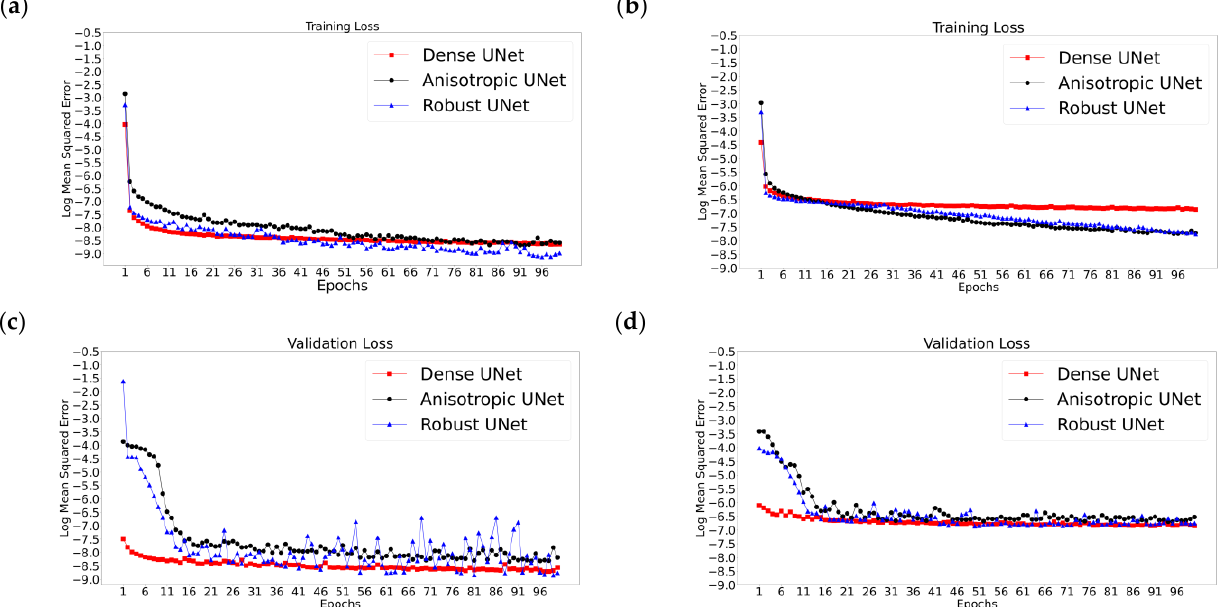
Figure 5. Representative results from the training sessions depicting the training ( a , b ) and the valida- tion ( c , d ) losses (as log mean squared error versus epochs) for the two acquisition scenarios: With- Prior ( a , c ) and the WithOut-Prior ( b , d ) information. These examples correspond to the worst-case scenario of upscaling 1/8 downsampled synLQ images toward the corresponding 176 × 208 synHQ. The networks were trained for 100 and 1000 epochs; the first 100 epochs are presented